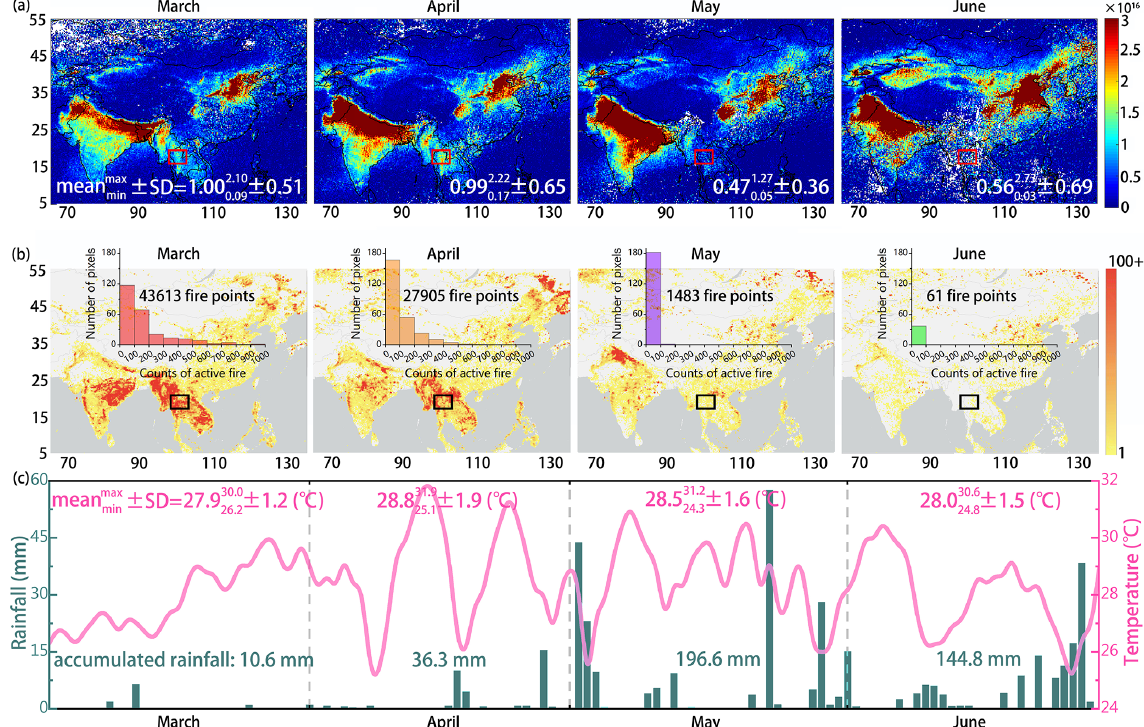
Figure 2. (a) Monthly (March–June) spatial distributions of the NH 3 total columns (molec.cm − 2 ) in 2018 obtained from satellite measure- ments by the Infrared Atmospheric Sounding Interferometer (IASI)/MetOp-A instrument in 0 . 25 ◦ × 0 . 5 ◦ cells. (b) Monthly distributions of gridded counts of active fire pixels (0 . 25 ◦ × 0 . 25 ◦ per cell) derived from the 375m Visible Infrared Imaging Radiometer Suite (VIIRS). The red and black squares indicate our study area in Chiang Mai. (c) Daily variations in temperature ( ◦ C) and rainfall (mm) in Chiang Mai city.